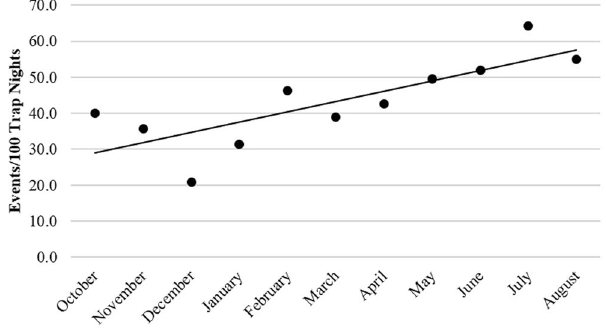
Figure 3. Events per 100 trap nights in all functioning connections of the 10 bridges that were still standing through August 2013 (September 2012 and 2013 were not included because not all camera traps were in place; N = 2,781 events; R 2 = 0.63, p <